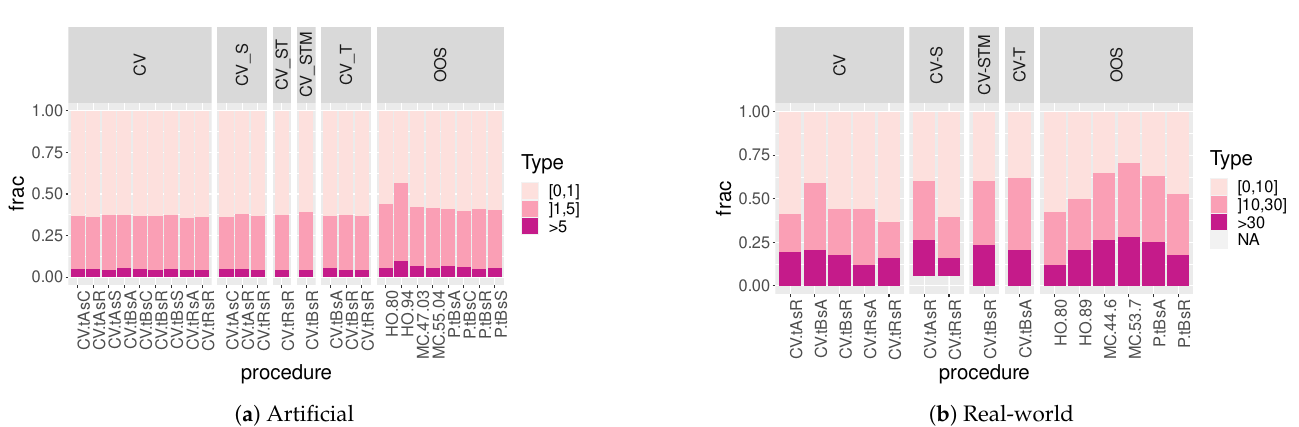
Figure 12. Bar plots of relative absolute estimation errors incurred by cross-validation and out-of-sample procedures on 192 artificial and 17 real-world datasets using four learning algorithms. Note the different legends.